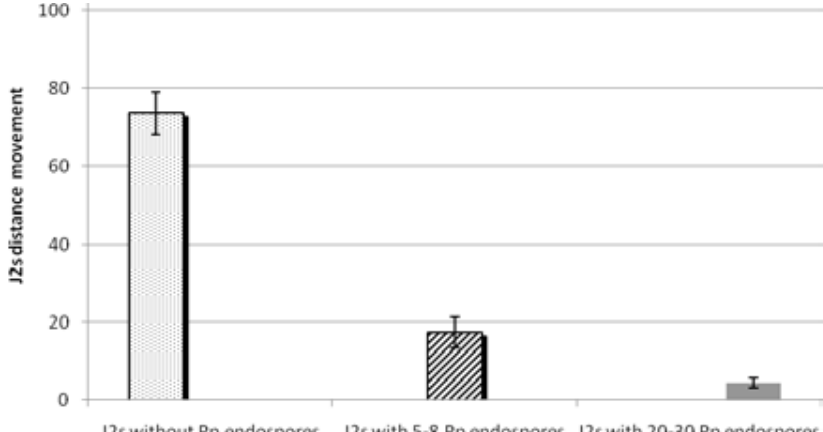
Figure 3. Differences in tracks of second-stage Meloidogyne javanica juveniles (J2s) with or without Pasteuria penetrans en- dospores observed in vitro . observations were made over 15 observed frames at 11.5 sec intervals. Dotted line represents a straight J2 body length which is equal to the value 105 in Y